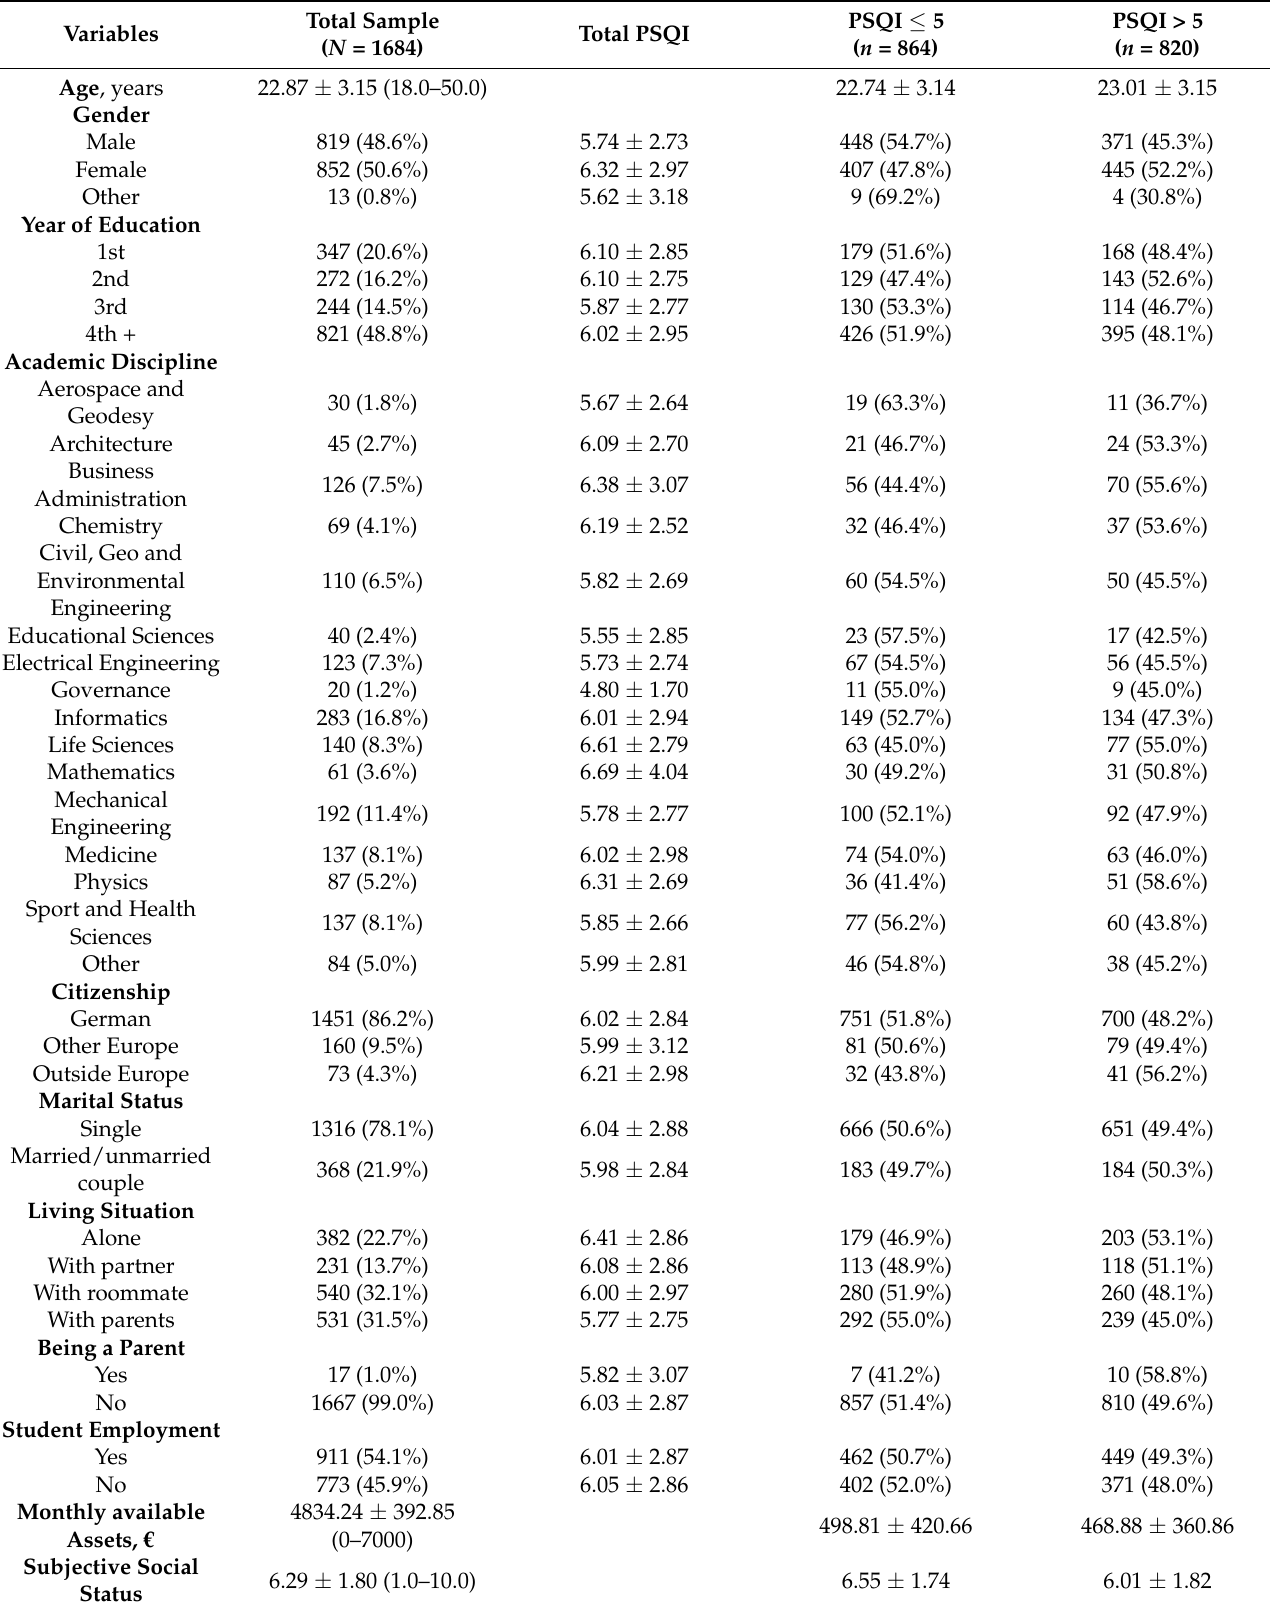
Table 1. Descriptive characteristics of socio-demographic indicators stratified by PSQI